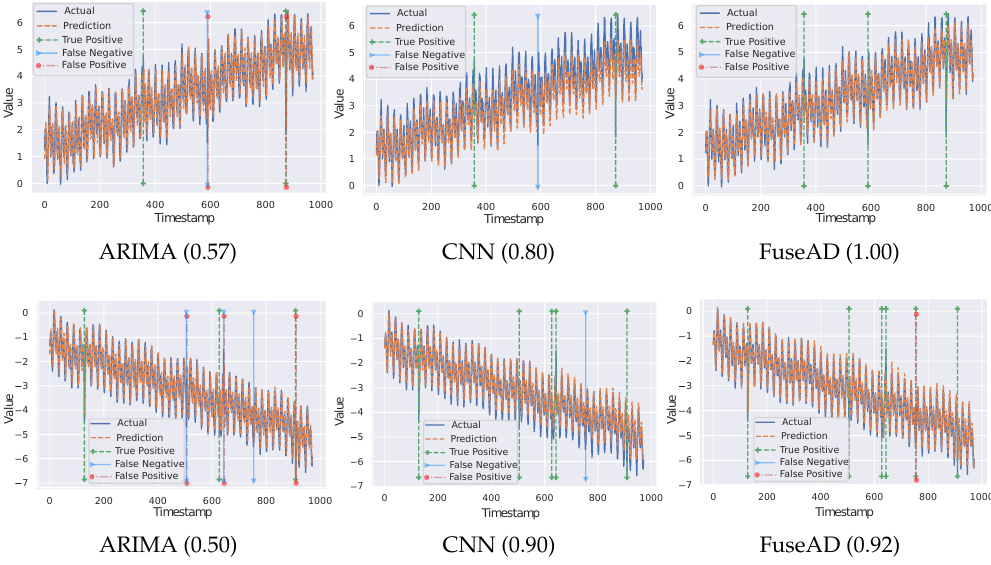
Figure 6. Comparative analysis of FuseAD and anomalies detected by ARIMA and CNN models on two sample time-series. The first row shows results on TS29 and the second row shows results on TS18 from the A3 Yahoo benchmark. Respective F-scores are shown in